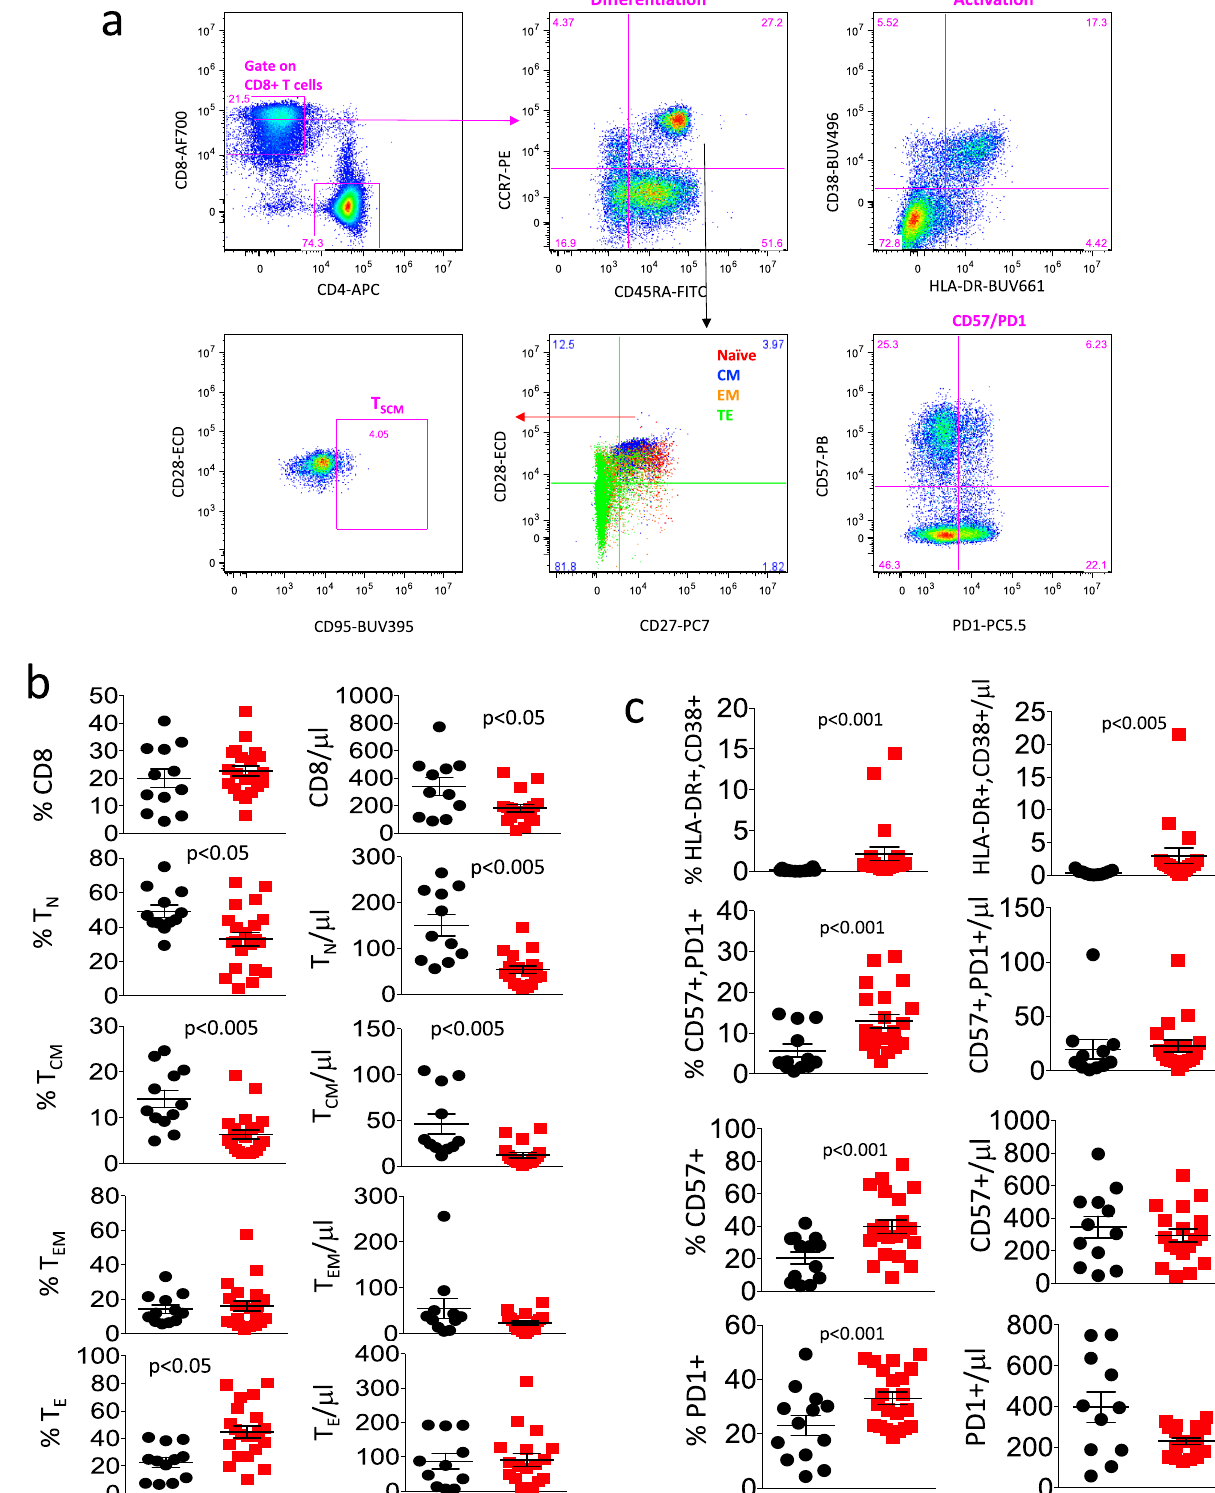
Detecting cytokine storm in patients ’ plasma . We measured plasma levels of 31 cytokines, chemokines, and immune-related molecules in 21 patients and 13 healthy controls (Fig. 7).